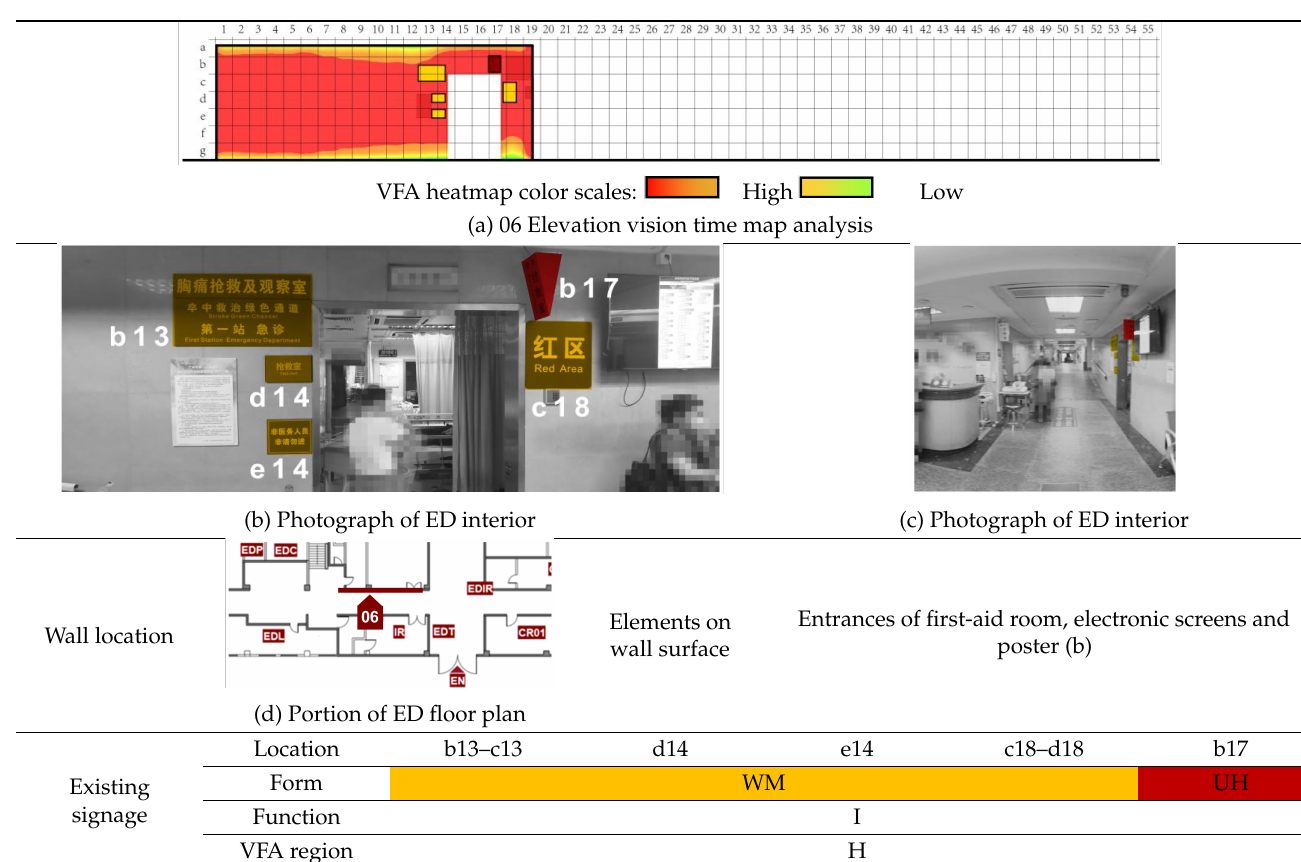
Table 10. 06 Elevation comparative analysis.